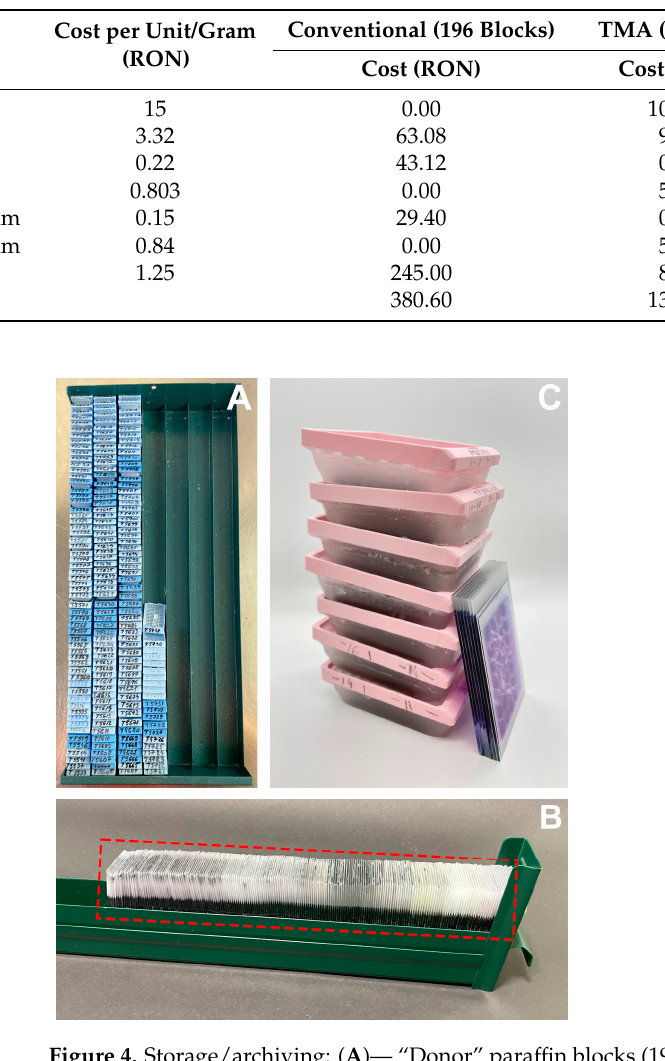
Table 2. Comparative cost of consumables between the conventional and the TMA methods. All prices are calculated based on 2022 average consumables market prices.